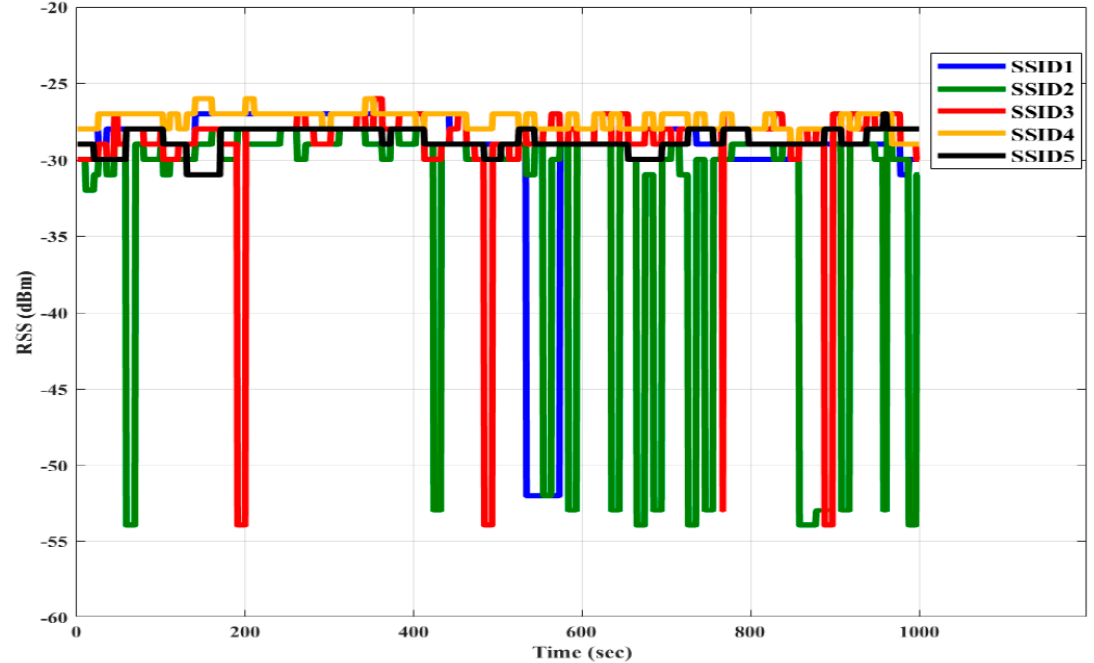
Figure 3. The MSSIDs’ signals time behavior.